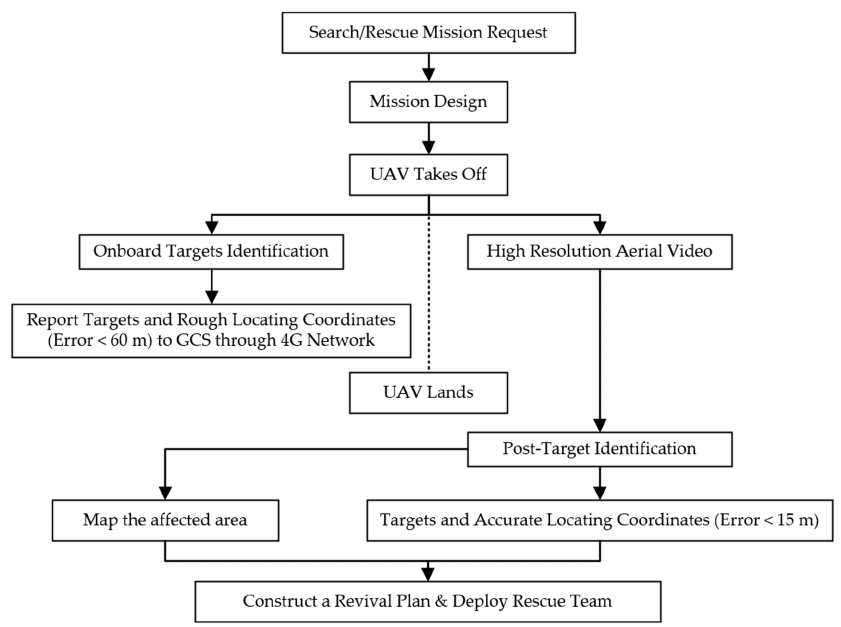
Figure 1. Flowchart of a wilderness SAR mission using the all-in-one